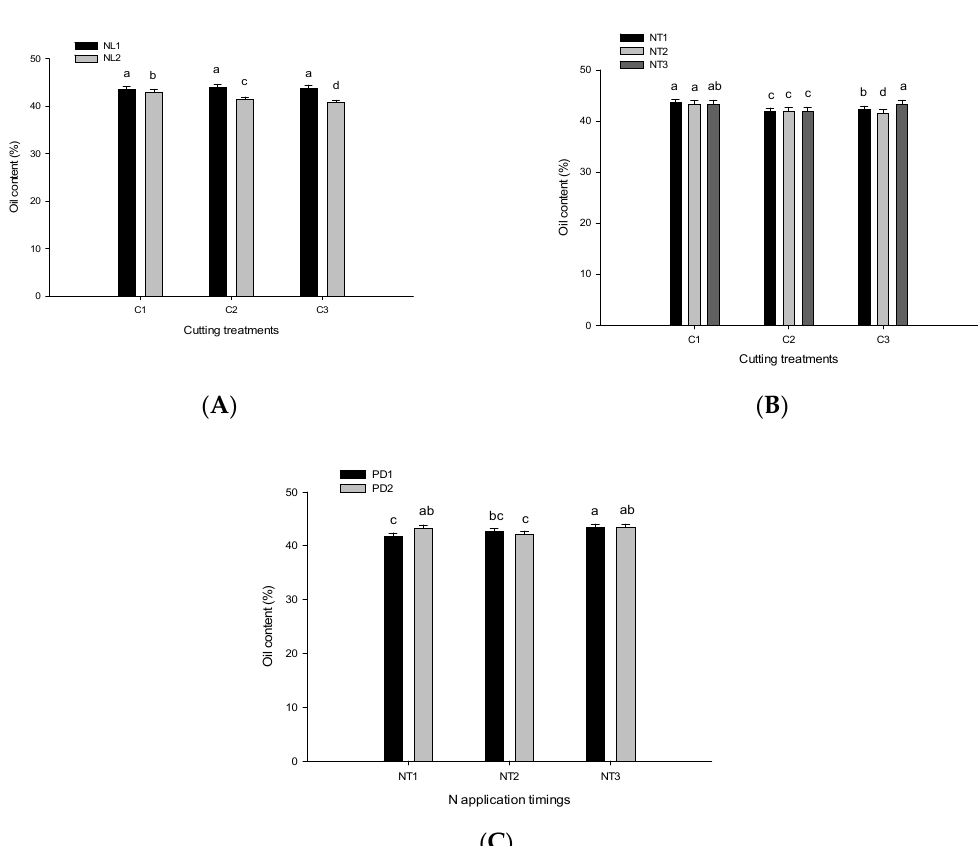
Figure 2. The interactive effects of nitrogen levels and cutting treatments ( A ), nitrogen application timings and cutting treatments ( B ), and nitrogen application timings and planting densities ( C ) for oil content. Vertical bars represent Standard Error. Note: Cuttings (C): no-cut (C 1 ), cutting (C 2 ), grazing (C 3 ); Nitrogen levels (NL): 80 kg ha − 1 (NL 1 ), 120 kg ha − 1 (NL 2 ); Nitrogen timings: Full application at sowing (NT 1 ), half dose of N both at sowing and start of rosette stage (NT 2 ), one third dose of N each at sowing, start of rosette stage and soon after cut at late rosette stage (60 days after sowing (NT 3 ); Planting density (PD): 20 plants m − 2 (PD 1 ), 40 plants m − 2 (PD 2 ).